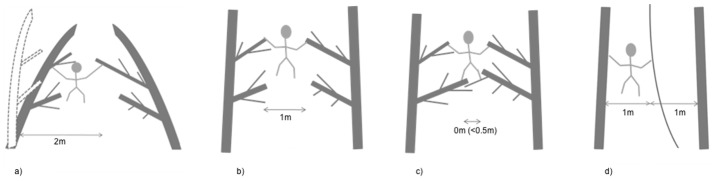
Illustrations of how the actual gap crossed by orangutans was estimated during different types of gap crossing.When the gap was crossed using mass deformation, the take-off point was the last location of the orangutan prior to support deformation (Fig 2a). For all other types of behaviour the take-off point was the last part of the take-off tree that the orangutan made contact with (Fig 2b). If this distance was estimated to be less than 0.5m the AGC was recorded as zero (Fig 2c). AGC was estimated to the nearest whole metre. In cases where a subject crossed a gap to get to a liana and then used the liana to get to the next tree, details of both crossings were recorded (Fig 2d).